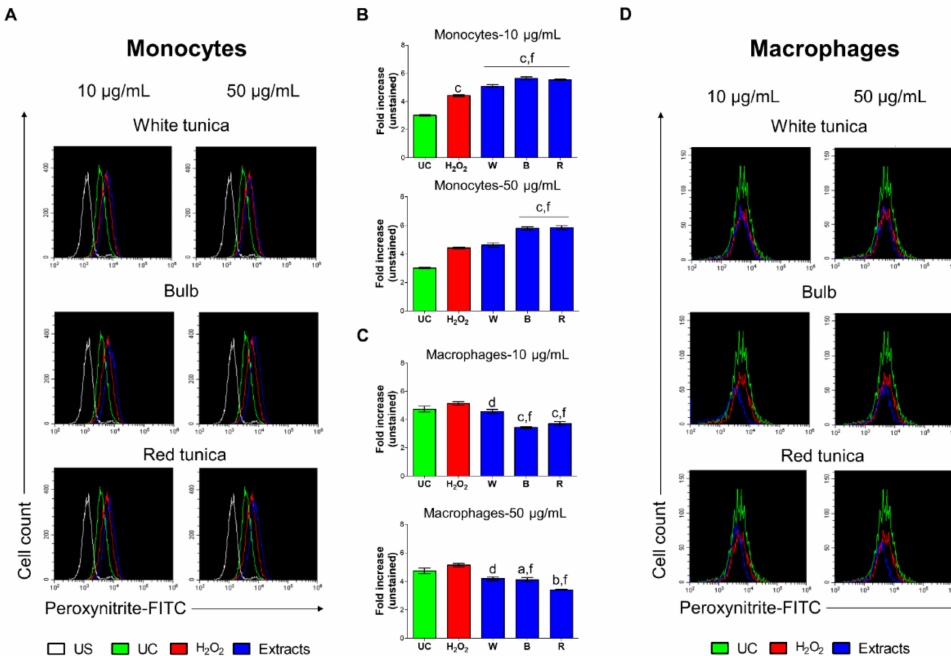
Figure 5. Generation of peroxynitrite by monocytes and macrophages after 48 h of exposure. ( A , D ) Histograms were obtained by flow cytometry and are generated by plotting the cell count ( y -axis) and the FITC fluorescence emission ( x -axis). ( B , C ) Bar graphs show the fold increase in the mean fluo- rescence intensities (MFIs) related to the emissions in the FL-1/FITC channel, which are proportional to the generation of peroxynitrite. Values are the ratios of the MFI generated from each sample on the unstained control (negative). a = p < 0.01, b = p < 0.001 and c = p < 0.0001 between treated samples and UC; d = p < 0.01, e = p < 0.001, and f = p < 0.0001 between samples and H 2 O 2 . UC = untreated control; US = unstained sample.